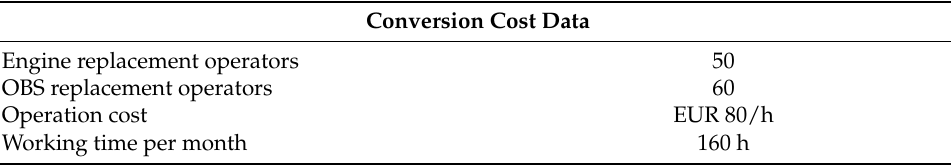
Table 7. The data assumed to compute the conversion costs.